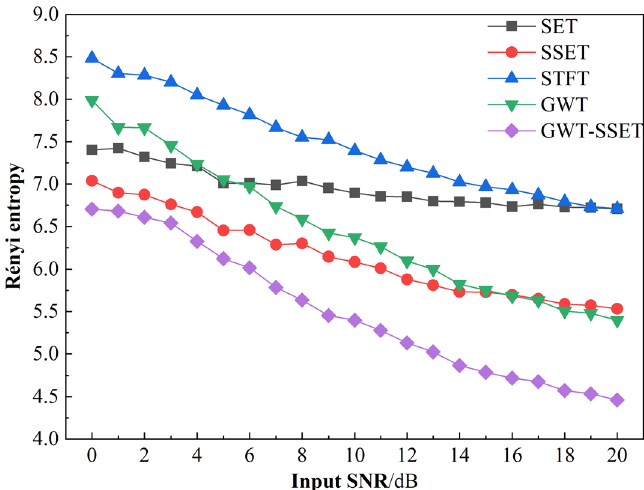
Figure 7. The Rényi entropy of TFR results.